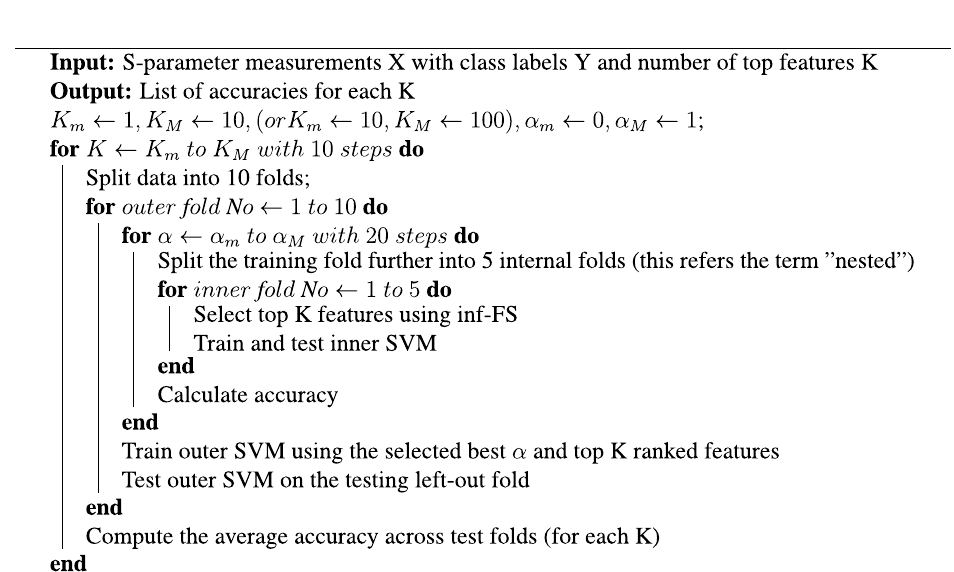
Figure 7. Flow chart for nested cross validation (CV) scheme.